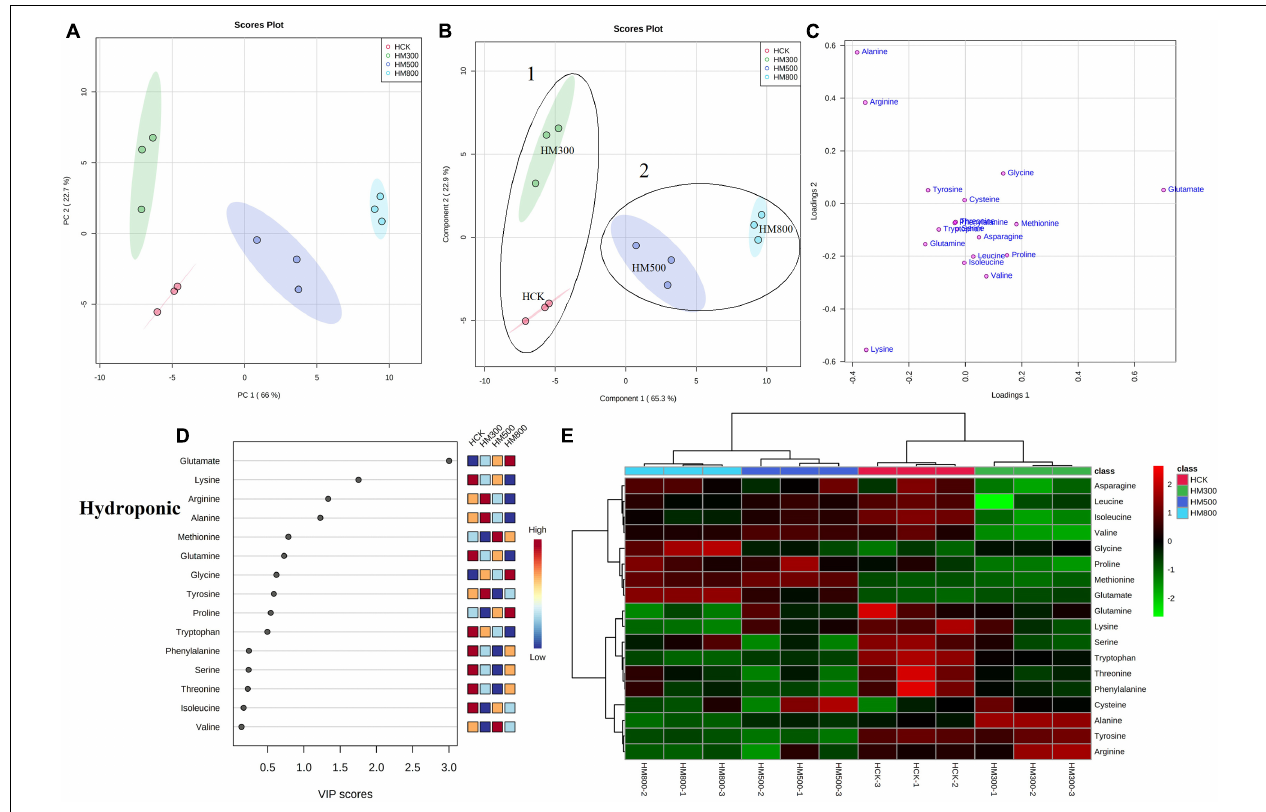
FIGURE 4 | Statistical analyses of bioactive metabolites in hydroponic Chinese chive treated with methyl jasmonate (MeJA). (A) An unsupervised principal component analysis (PCA) score plot of amino acid metabolites. (B) A partial least squares discriminant analysis (PLS-DA) score plot of amino acid metabolites. (C) PLS-DA score plots loaded with different amino acid metabolites. (D) VIP scores of amino acid metabolites in PLS-DA. The scores from low to high determine the importance of variables. The colored boxes on the right show the relative concentration of each metabolite from low (blue) to high (red). (E) Heat map of amino acid concentrations. The colored areas correspond to the concentrations of different amino acids from low (green) to high (red) in groups treated with different concentrations of MeJA. Each row represents an amino acid, and each column represents a